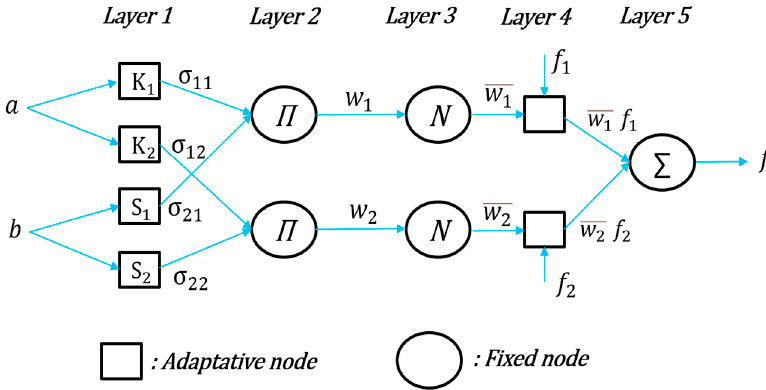
Figure 9. Two-entry ANFIS architecture for two rules.